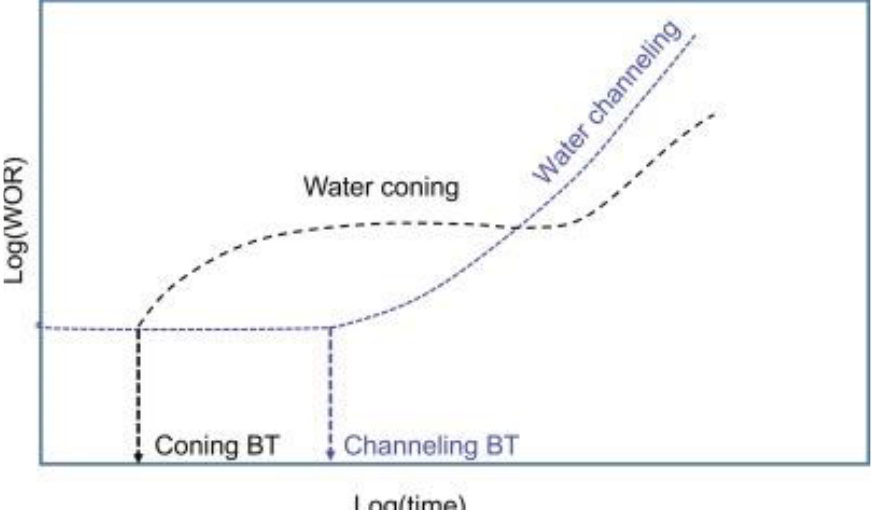
Figure 1. Water coning and channeling WOR comparison [5].